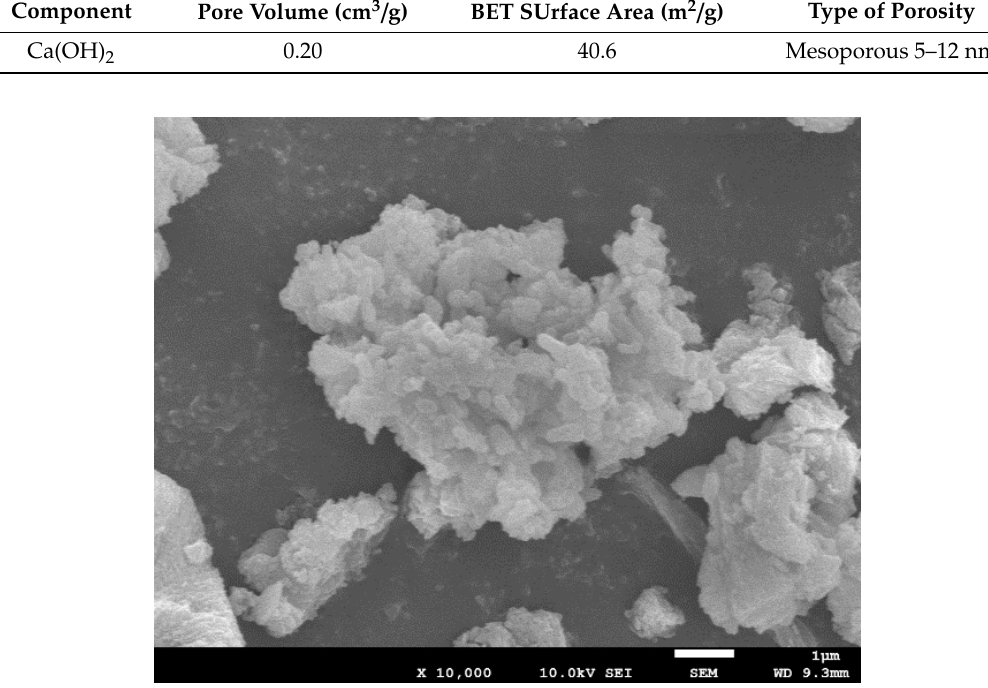
Figure 4. SEM imaging of Ca(OH) 2 particles.